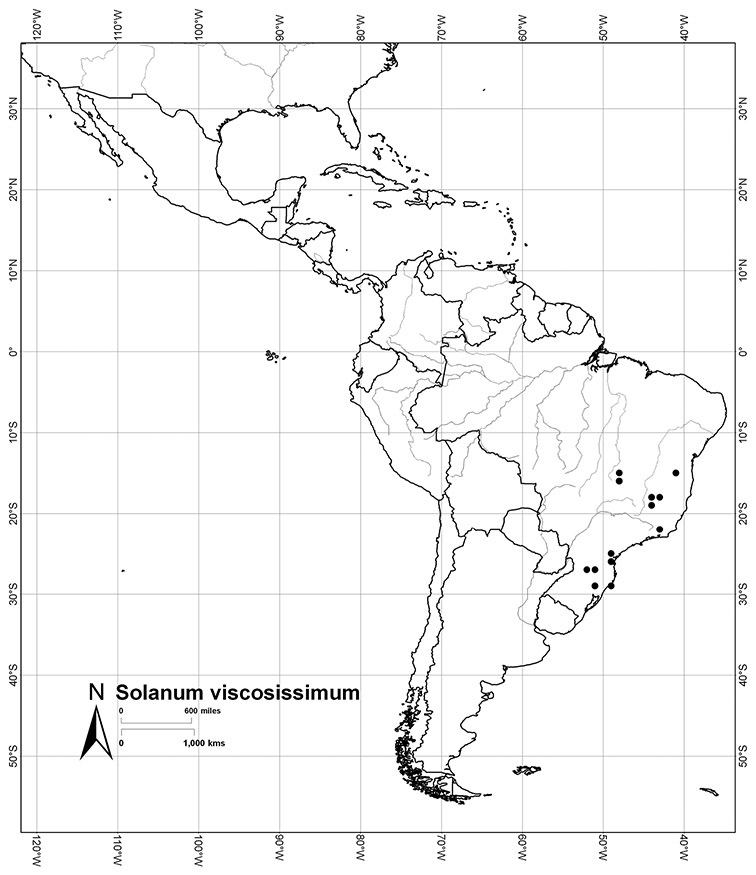
Distribution of Solanumviscosissimum Sendtn.